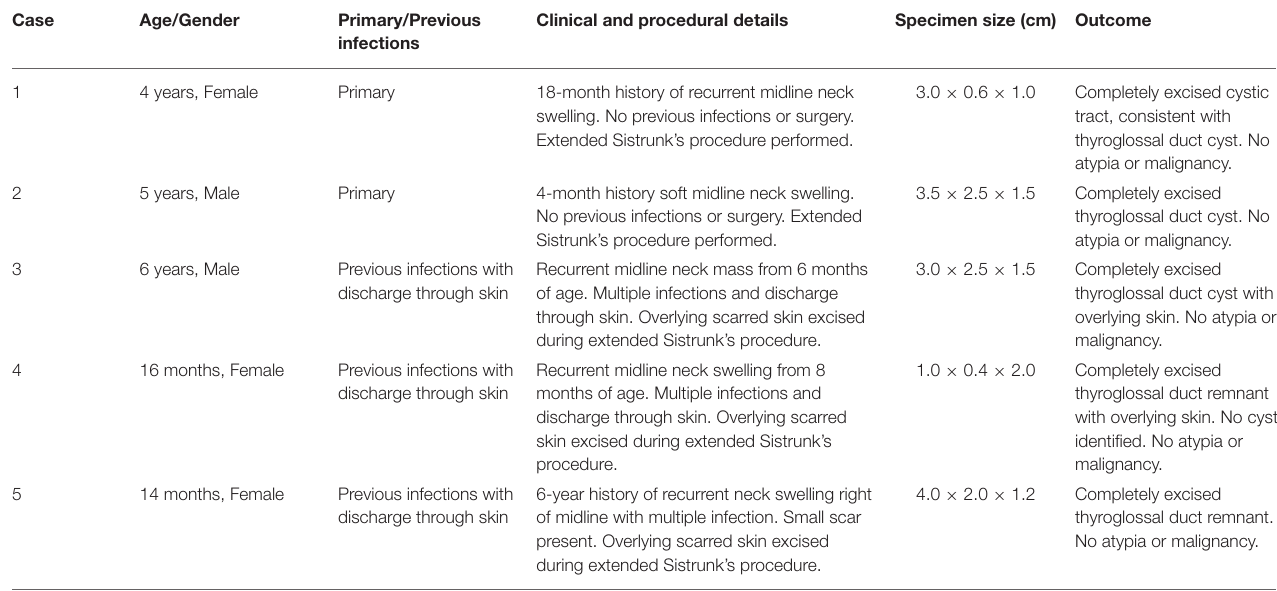
TABLE 1 | Patient demographics and clinical details.